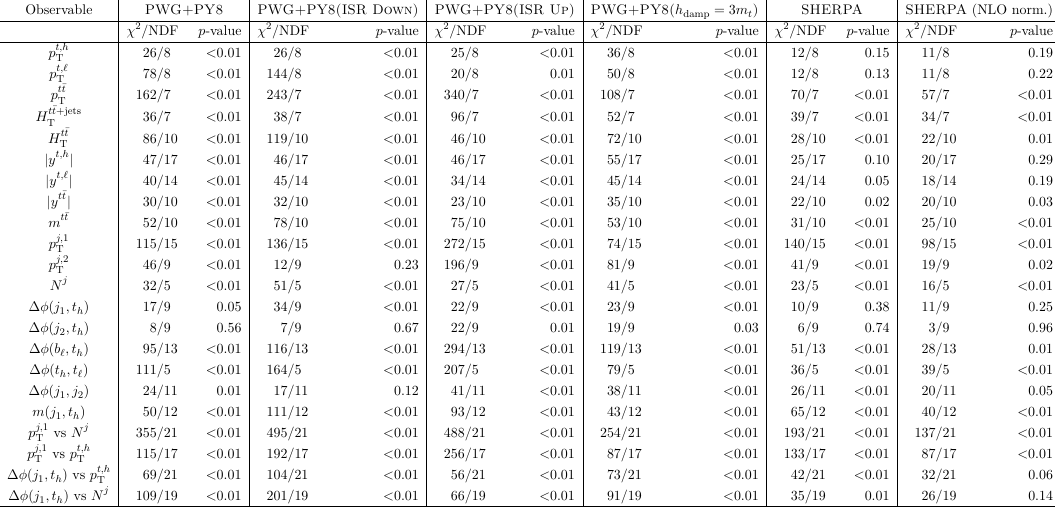
Table 4. χ 2 and p -values quantifying the level of agreement between the absolute unfolded spec- tra and several NLO+PS predictions. PWG+PY8 corresponds to the Powheg+Pythia sample. SHERPA (NLO norm.) refers to the Sherpa sample with its default normalisation. All other samples are normalised to the inclusive NNLO+NNLL t ¯ t cross-section